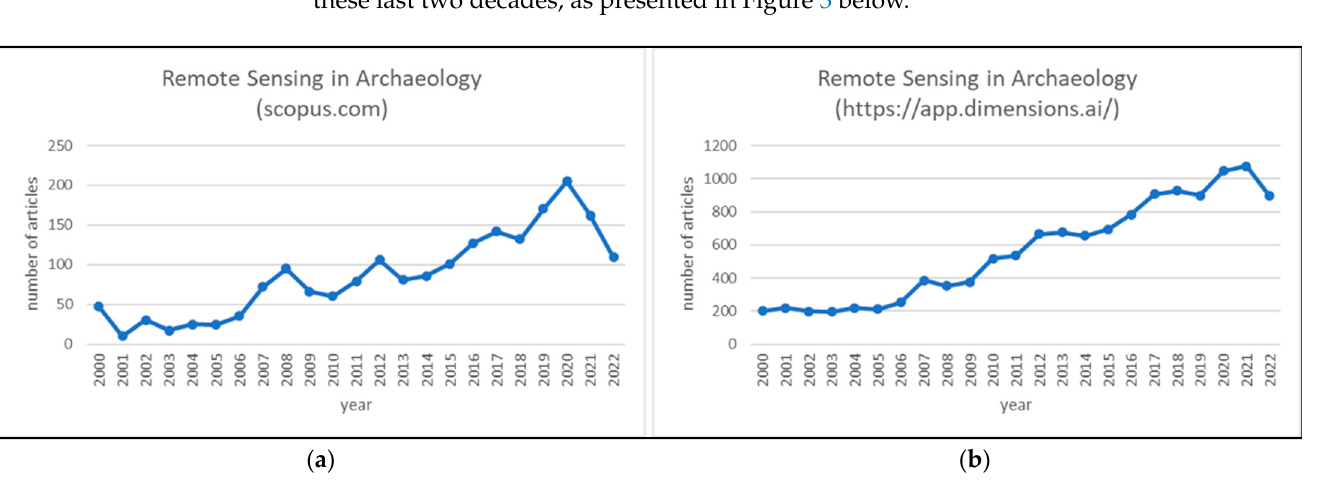
Figure 3. Annual publications of Remote Sensing in Archaeology since 2000 ( a ) source: Scopus.com (accessed on 15 October 2022), ( b ) source: https://www.dimensions.ai (accessed on 10 November 2022).